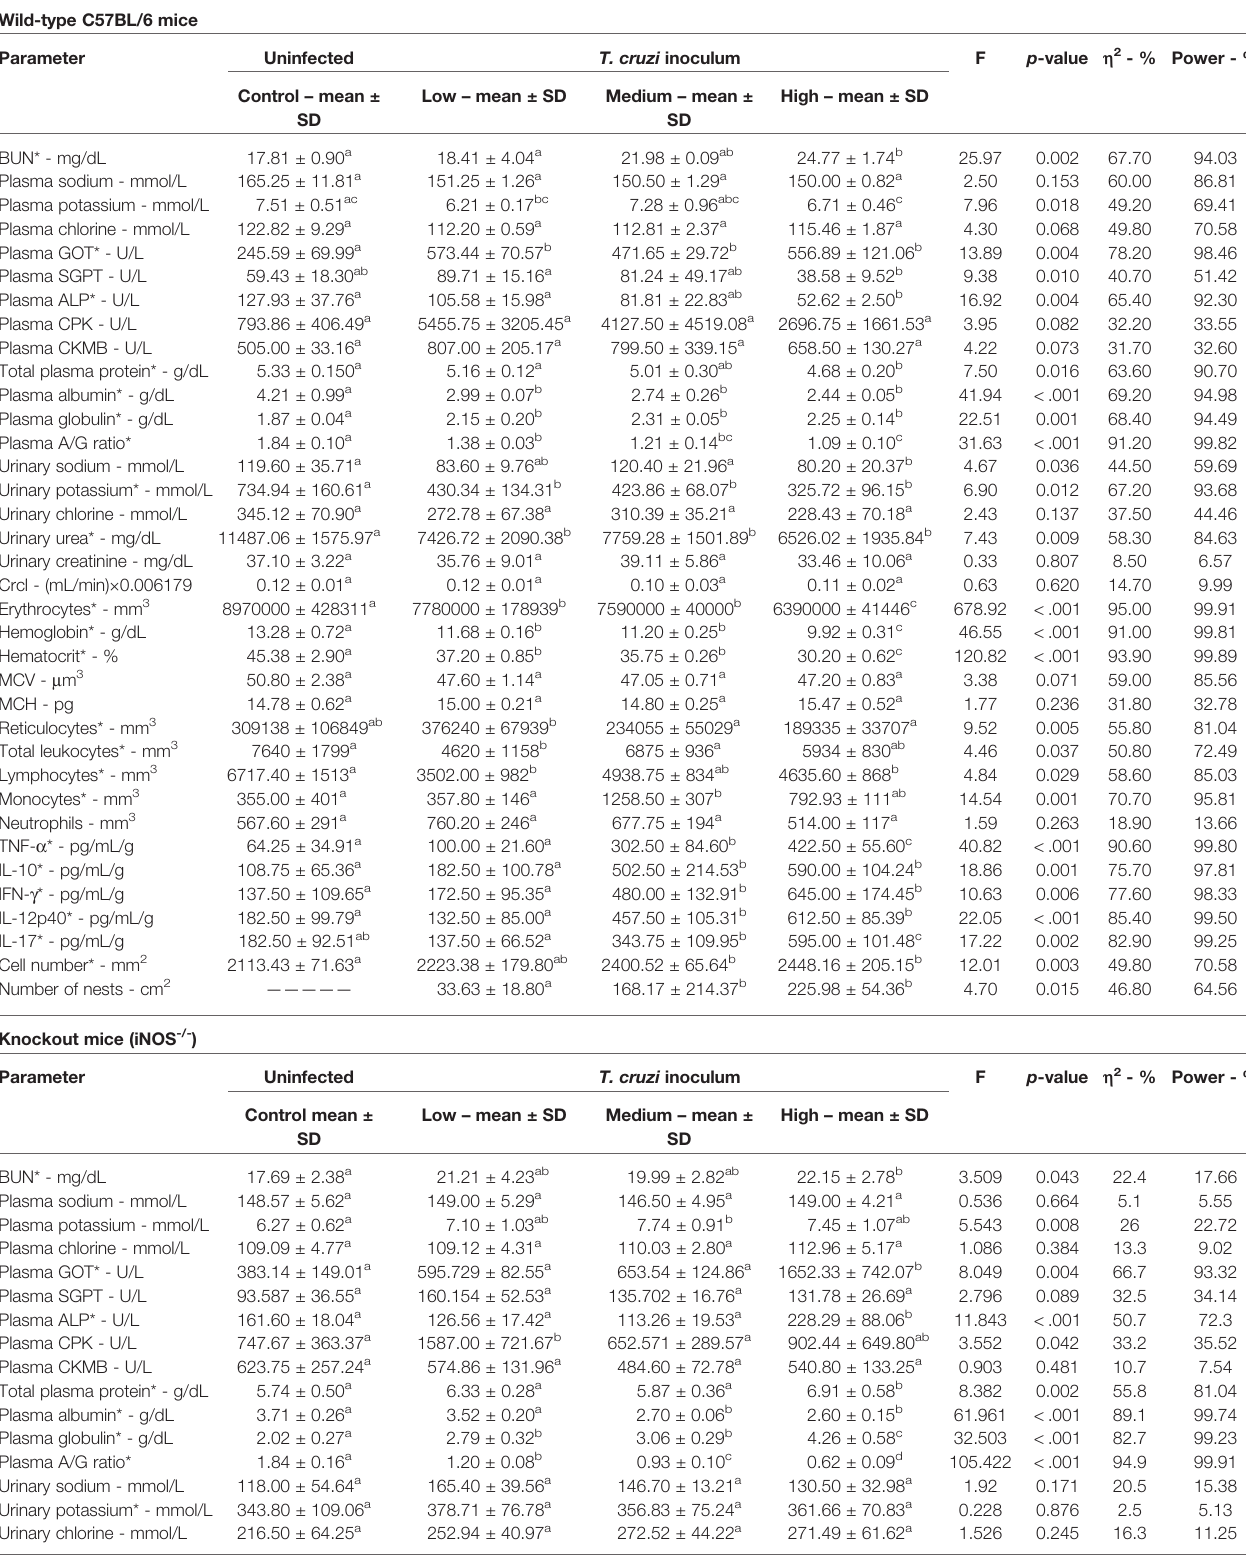
TABLE 1 | Effects of different Trypanosoma cruzi inoculum concentrations (low, medium, and high) of the “ Y ” strain on clinical laboratory markers, in fl ammatory, and histopathological parameters in wild-type C57BL/6 and knockout (iNOS -/- ) mice in the acute phase of infection (after 12 days of infection). Wild-type C57BL/6 mice